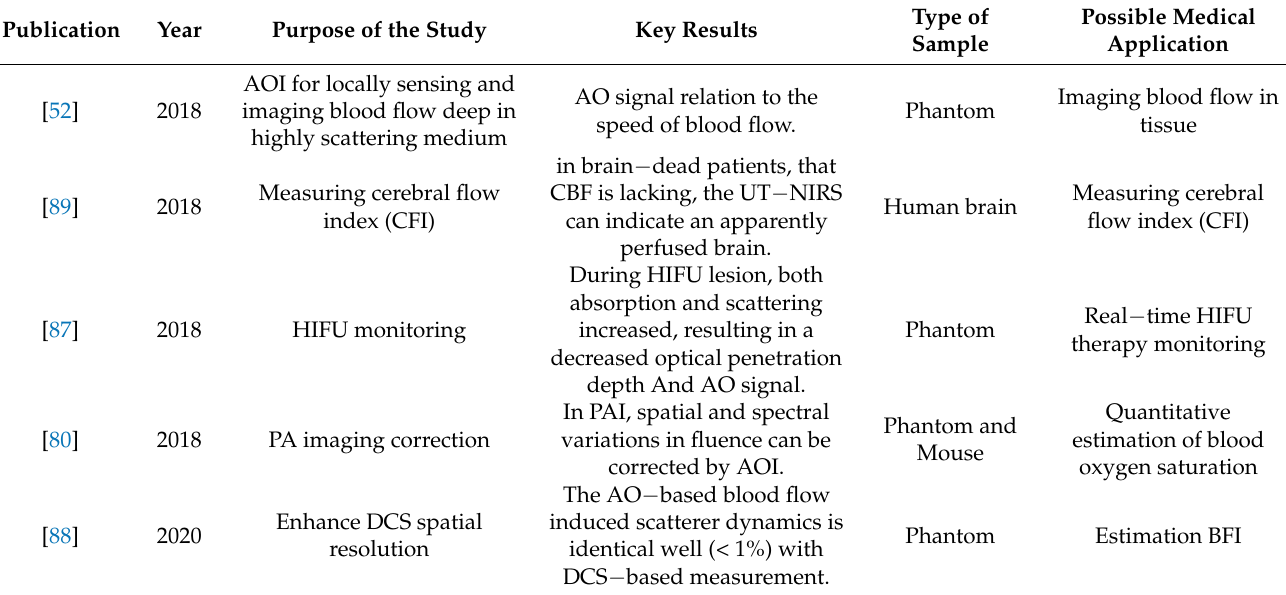
Table 1. A summary of selected AO studies published between